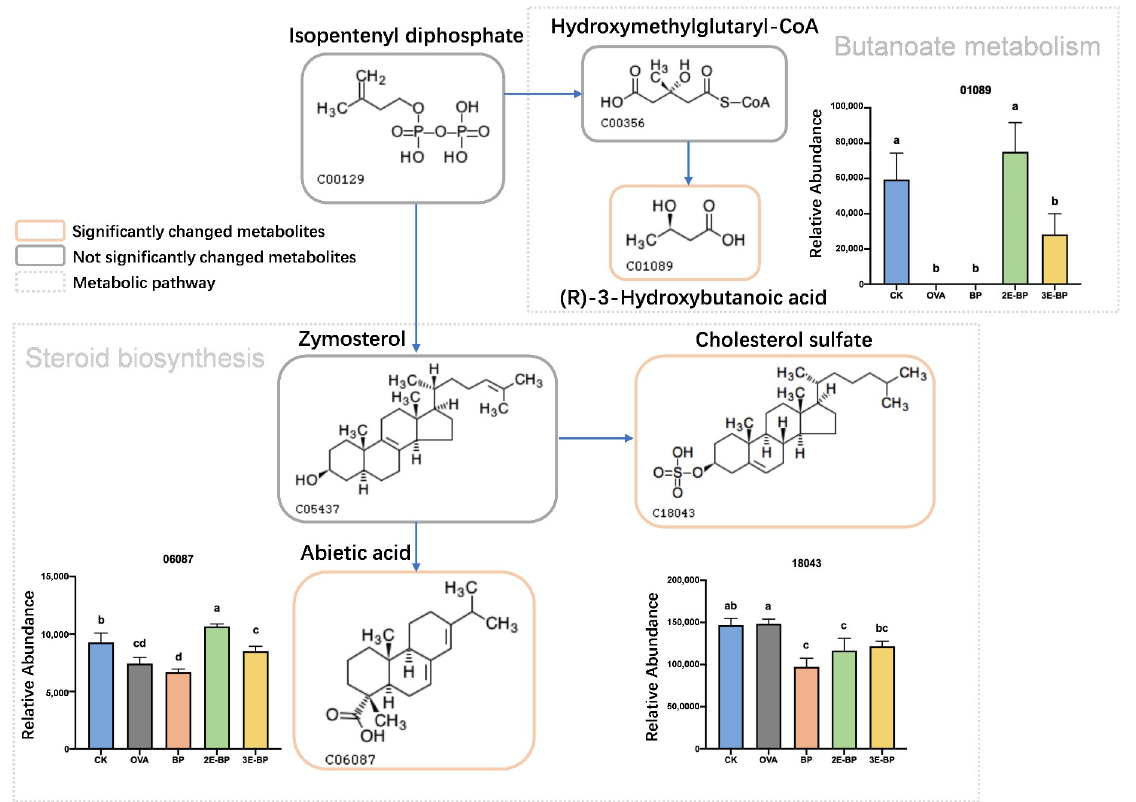
Figure 4. The changed metabolites and involved metabolic pathways in mice serum of different treatments groups. Different letters indicate a significant difference among different groups ( p < 0.05).